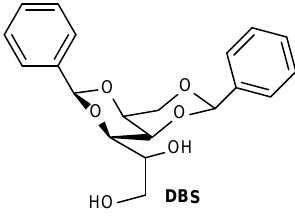
Figure 1. 1,3:2,4-Dibenzylidene- D -sorbitol (DBS), 1 .